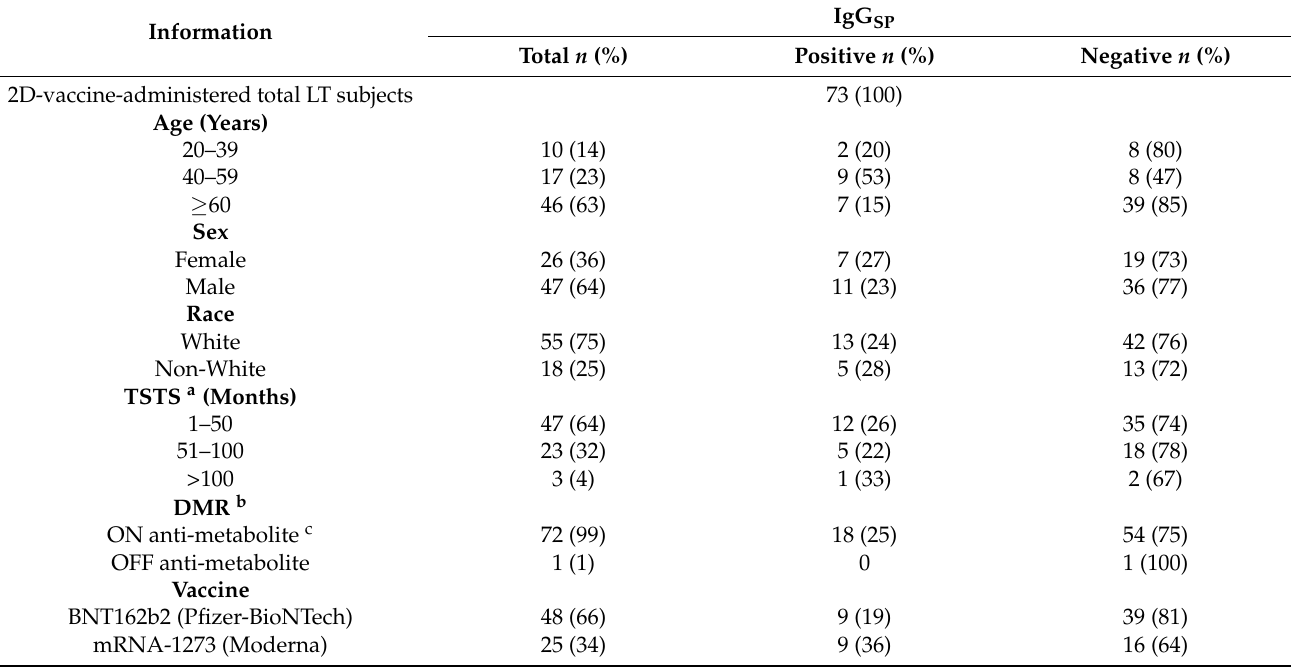
Table 1. Demographic and clinical characteristics of study participants stratified by spike-specific IgG (IgG SP ) antibody response after two-dose-COVID-19 vaccination.